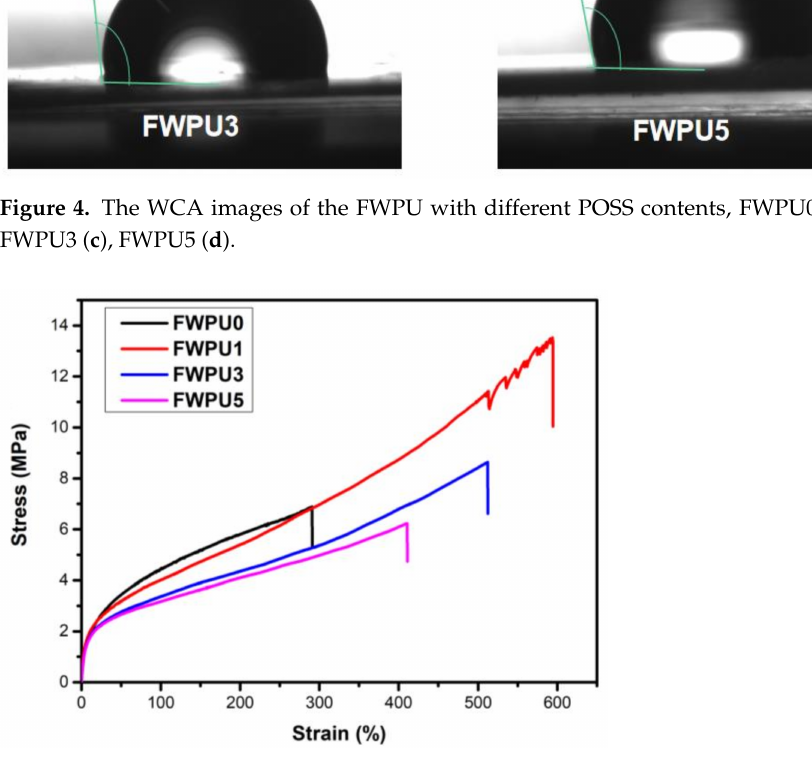
Figure 5. The tensile stress-strain curves of FWPU films with different POSS